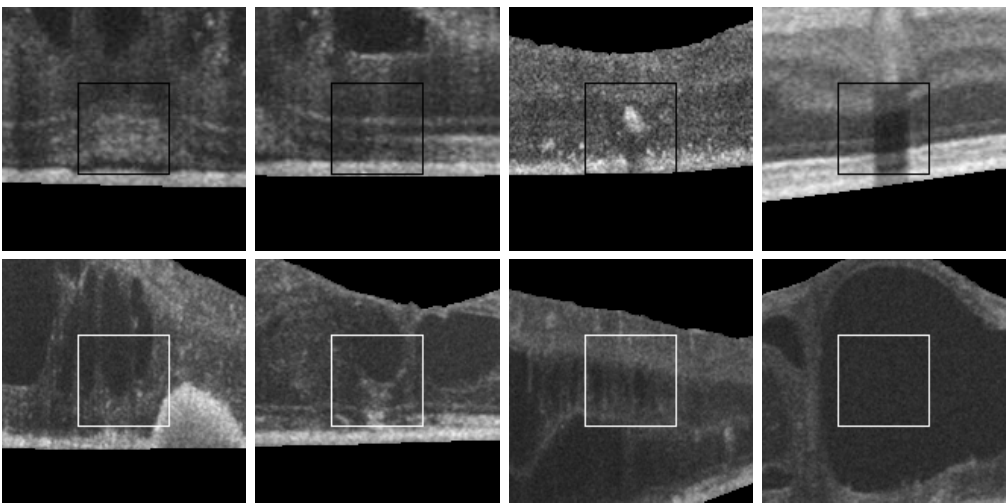
Figure 14. Randomly selected samples from the test dataset labeled by experts that were correctly classified by the automatic system. 1st row, non-cystoid regions. 2nd row, cystoid regions.